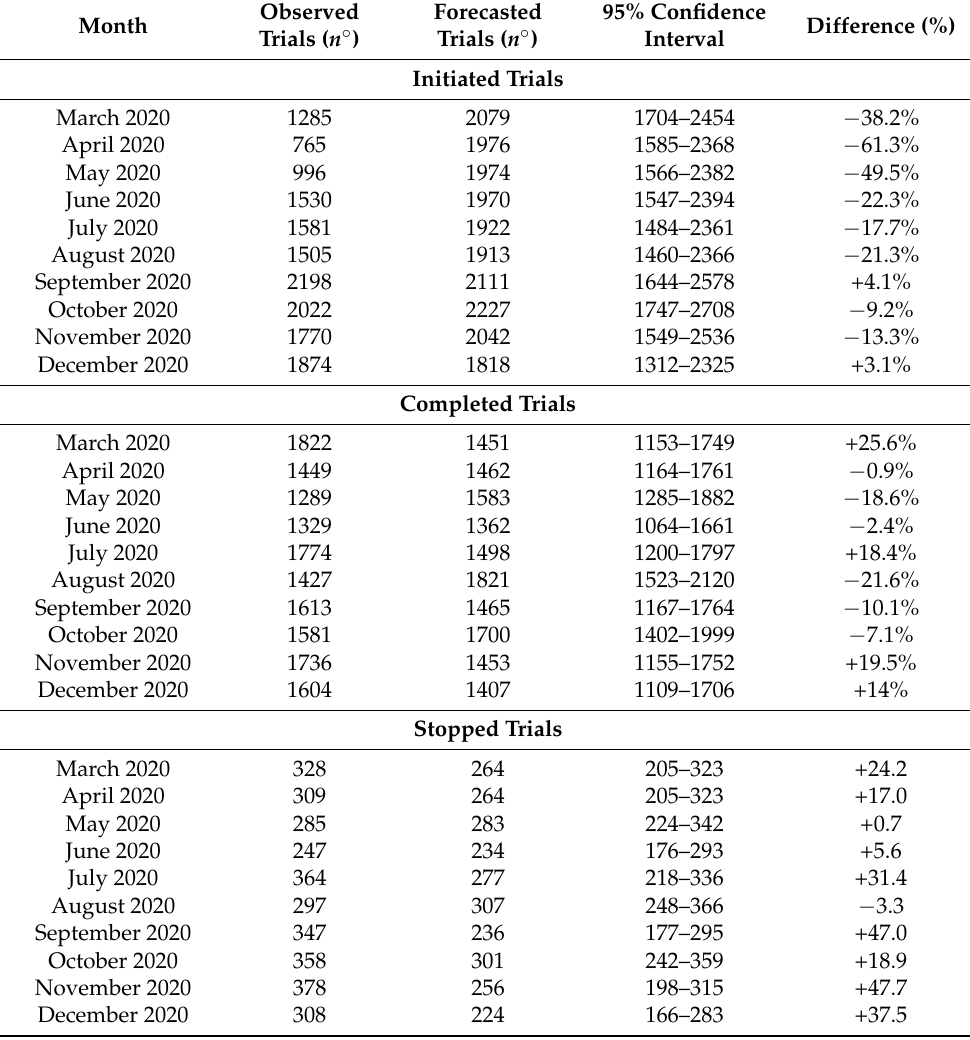
Table 2. Number of observed and predicted initiated, completed, and stopped non-COVID-19